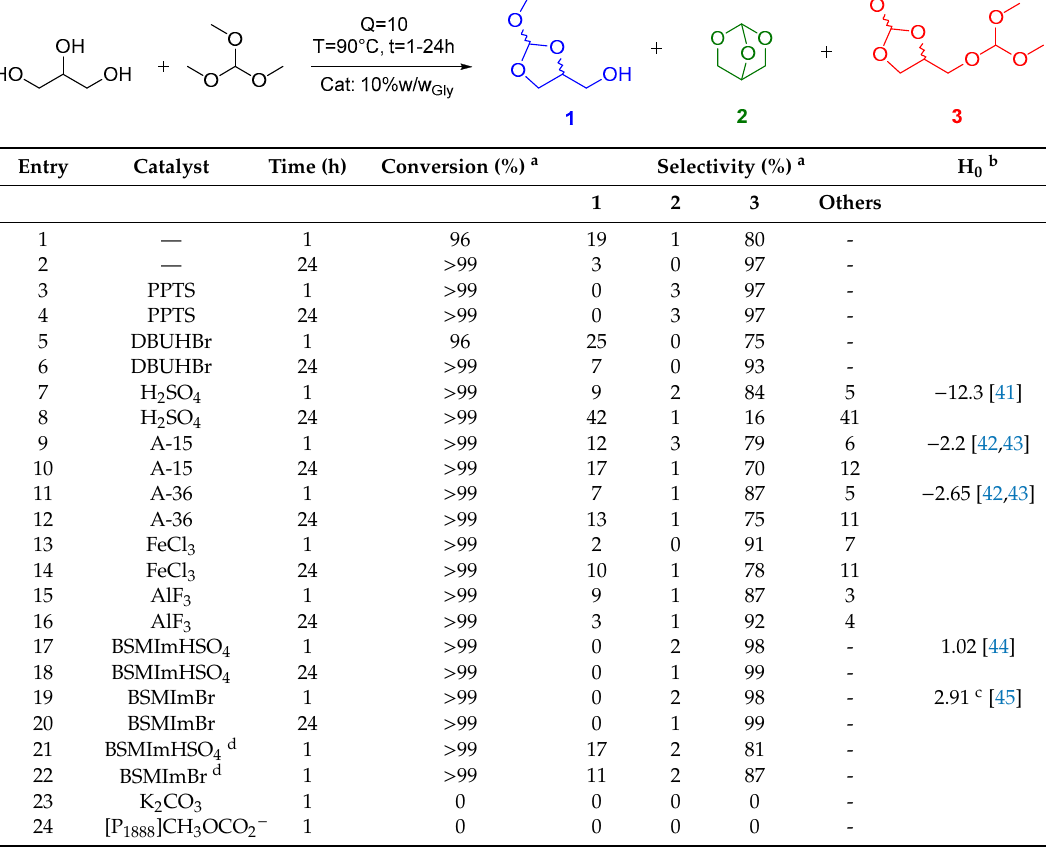
Table 2. Catalyzed reaction between HC(OMe) 3 and Gly.